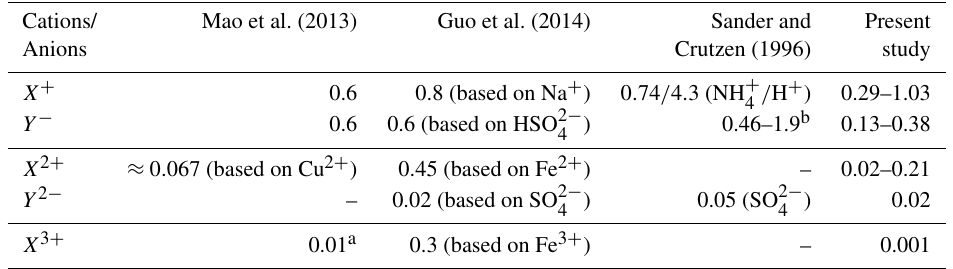
Table 3. Comparison of activity coefficients applied in multiphase aerosol chemistry models. The data of the present study are based on Table 1.